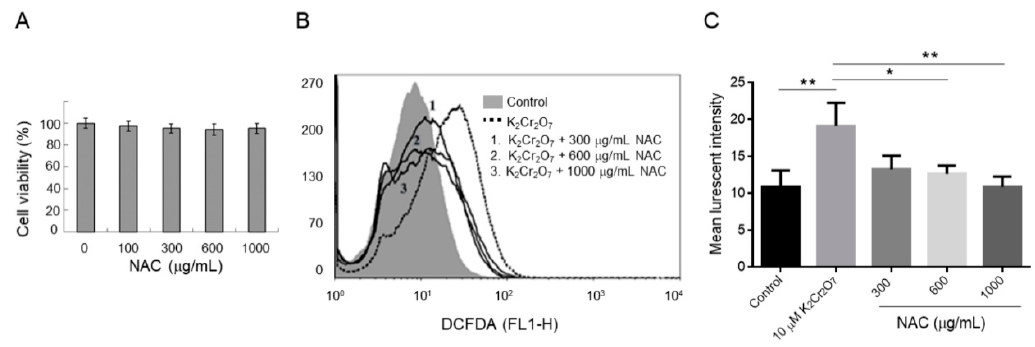
Figure 2. E ff ect of N-acetylcysteine (NAC) treatment on intracellular reactive oxygen species (ROS) of K 2 Cr 2 O 7 -induced cytotoxicity in HK-2 cells. ( A ) Cell viability at 24 h after exposure to di ff erent concentrations of NAC in HK-2 cells. ( B ) Detection of ROS levels by flow cytometry with di ff erent NAC in K 2 Cr 2 O 7 -treated HK-2 cells. The filled gray area indicates the control group and the dashed line indicates the 10 µ M K 2 Cr 2 O 7 -treated group. The numbers 1, 2, and 3 indicate HK-2 cells exposed to 10 µ M K 2 Cr 2 O 7 and (1) 300 µ g / mL NAC, (2) 600 µ g / mL NAC, and (3) 1,000 µ g / mL NAC. ( C ) Quantification of ROS levels. Data are presented as mean ± SD. * P < 0.05, ** P < 0.01, when compared with the 10 µ M K 2 Cr 2 O 7 -treatment group.